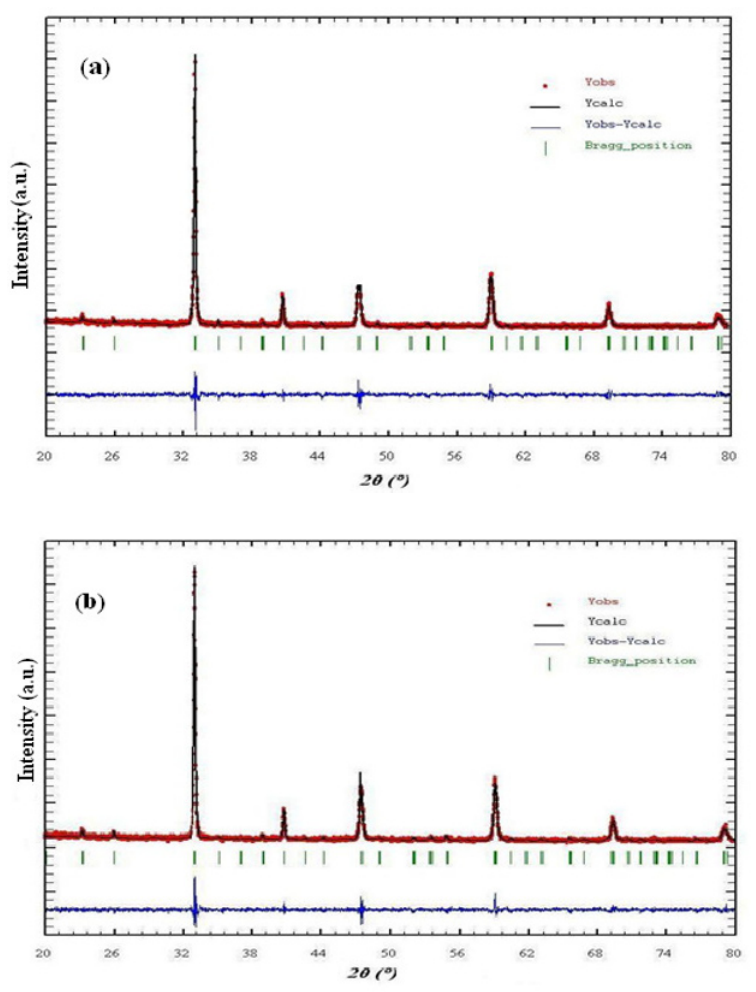
Fig.1. X-ray powder diffraction patterns and refinement for La